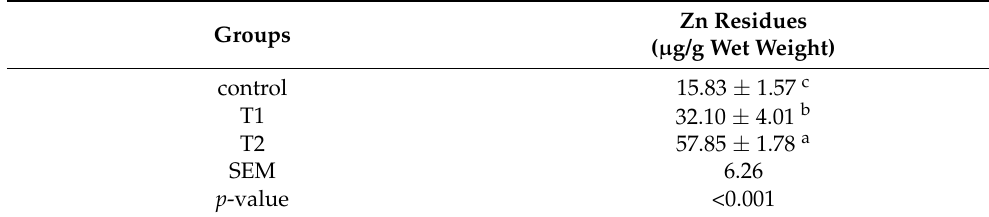
Table 2. Accumulation of ZnO-NPs residues in the whole body of treated female zebrafish ( µ g/g wet